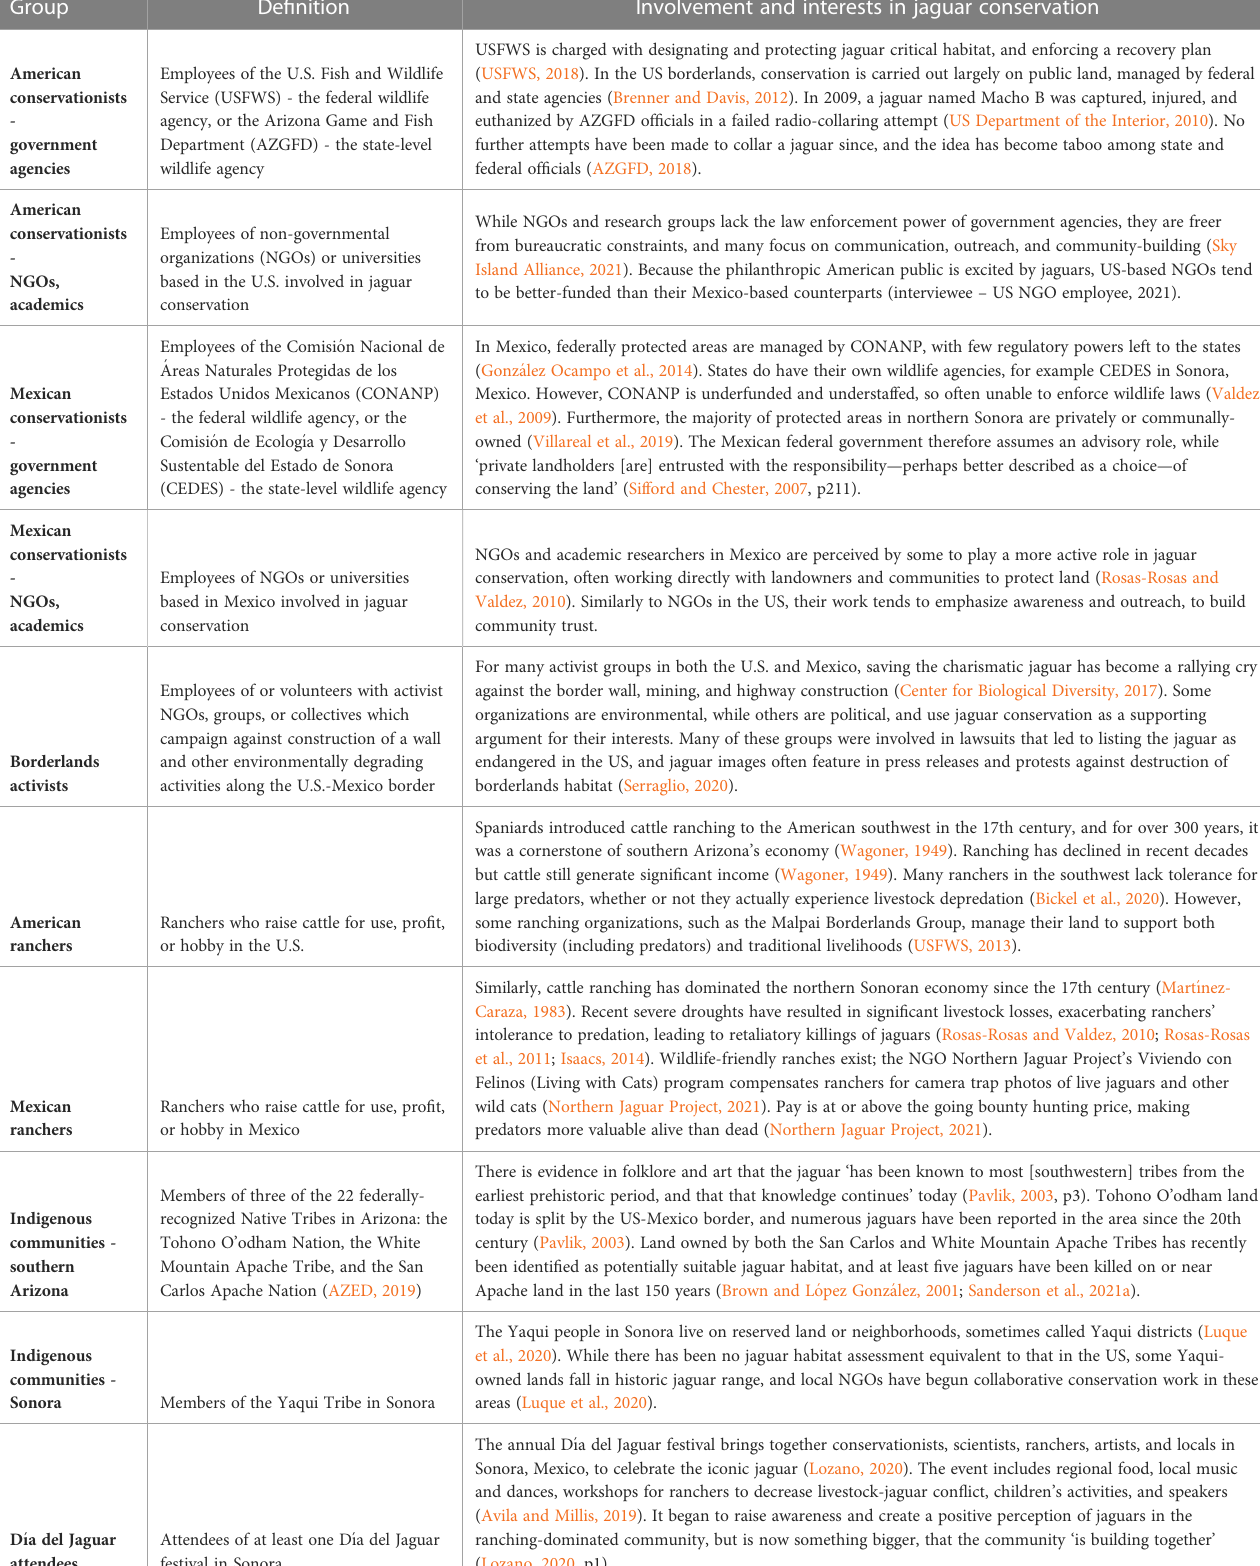
TABLE 1 Information describing the ten stakeholder groups interviewed in this study. Group De fi nition Involvement and interests in jaguar